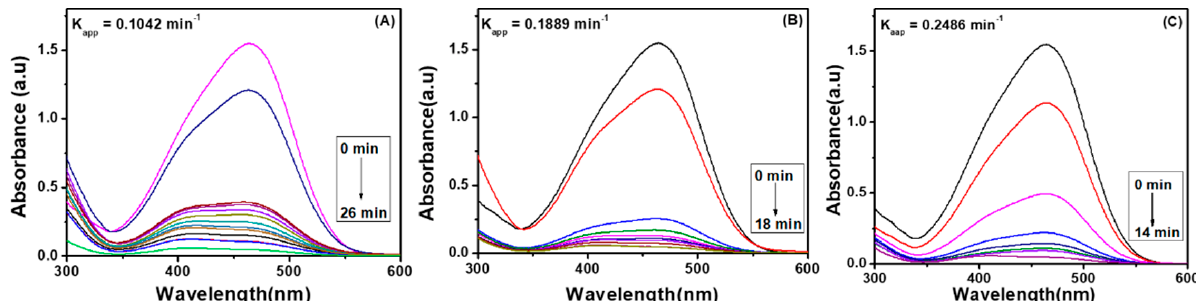
Figure 5. UV-Visible spectra for degradation of Methyl orange (dye) and its apparent rate constant values by using Ag-embedded NIPAM-based cryogels (CR-Ag) at different catalyst concentra- tions;( A ) 0.05 g ( B ) 0.10 g ( C ) 0.15 g.